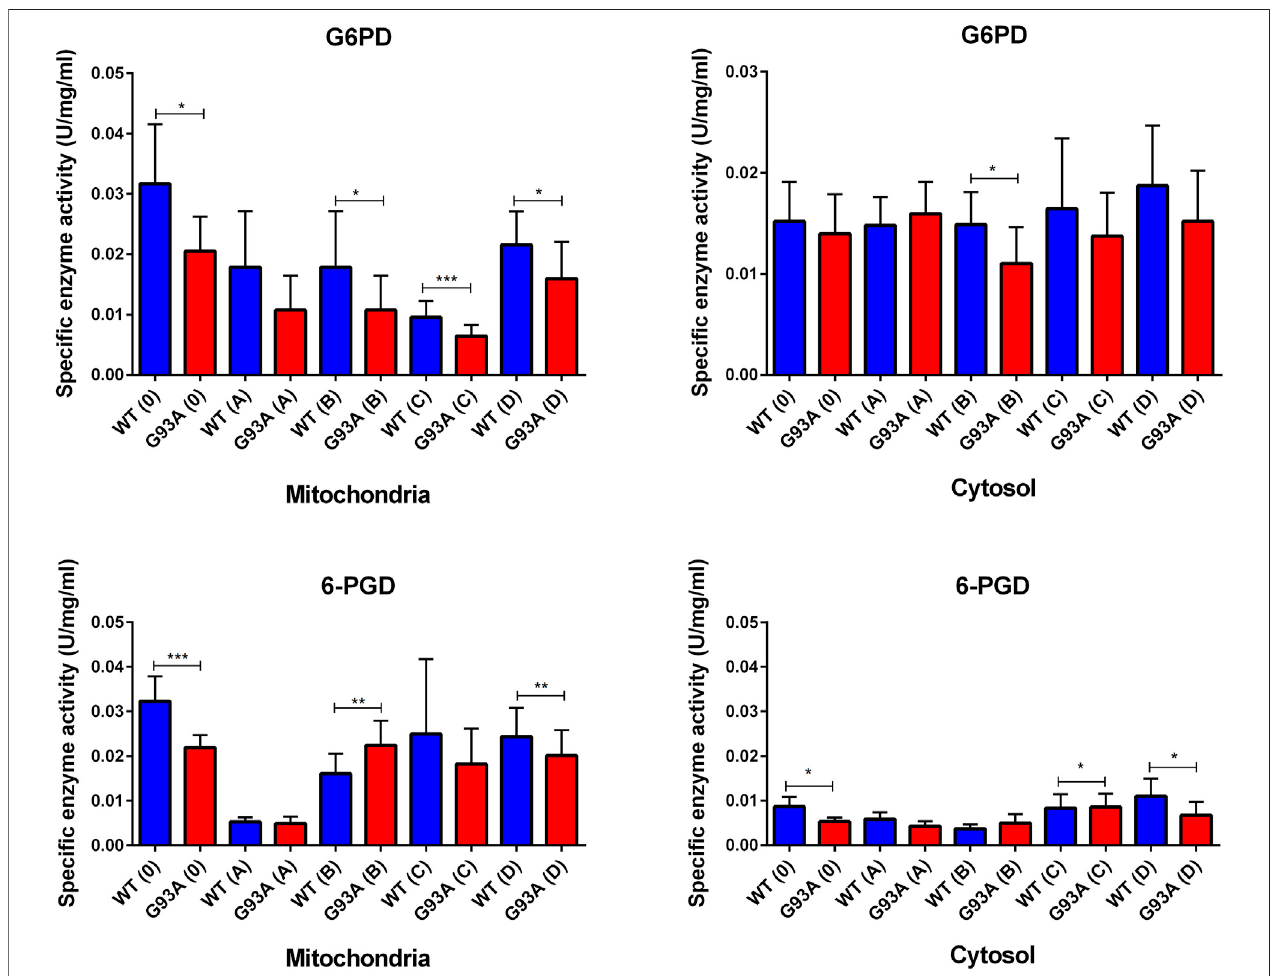
FIGURE 7 | G6PD and 6-PGD enzymes belonging to the PPP were evaluated in both cytosol and mitochondria of lung tissues of SOD1 WT (WT) and SOD1 G93A (G93A) rats. Data were given as mean ± SD of n = 8 animals for each group. Notes: * p ≤ 0.05, ** p ≤ 0.001 and *** p ≤ 0.0001.